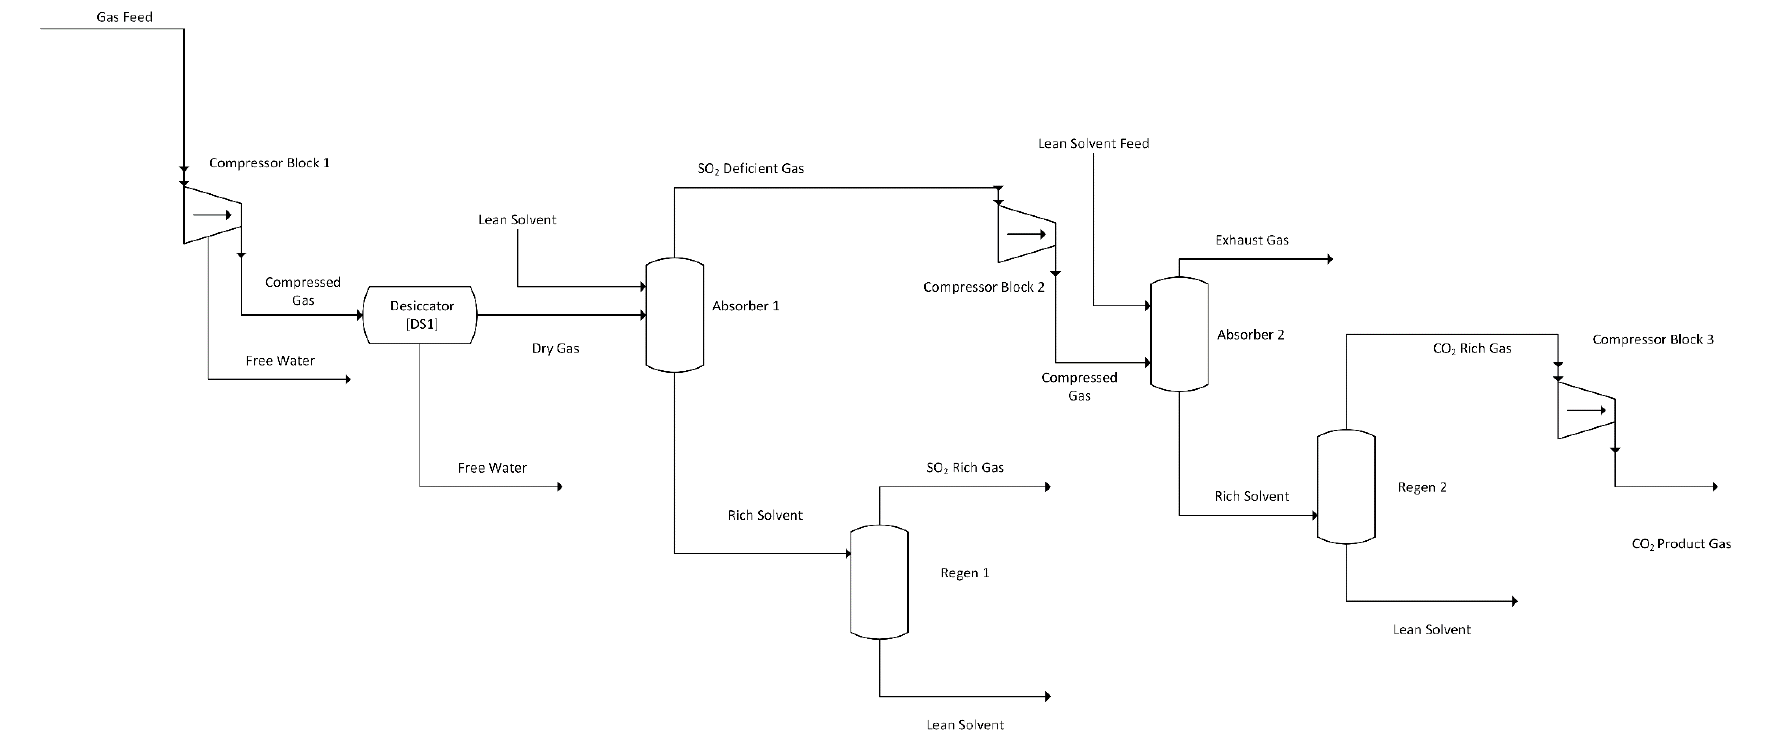
Figure 1. DES Dual-Stage Absorption System Simplified Flow Diagram.